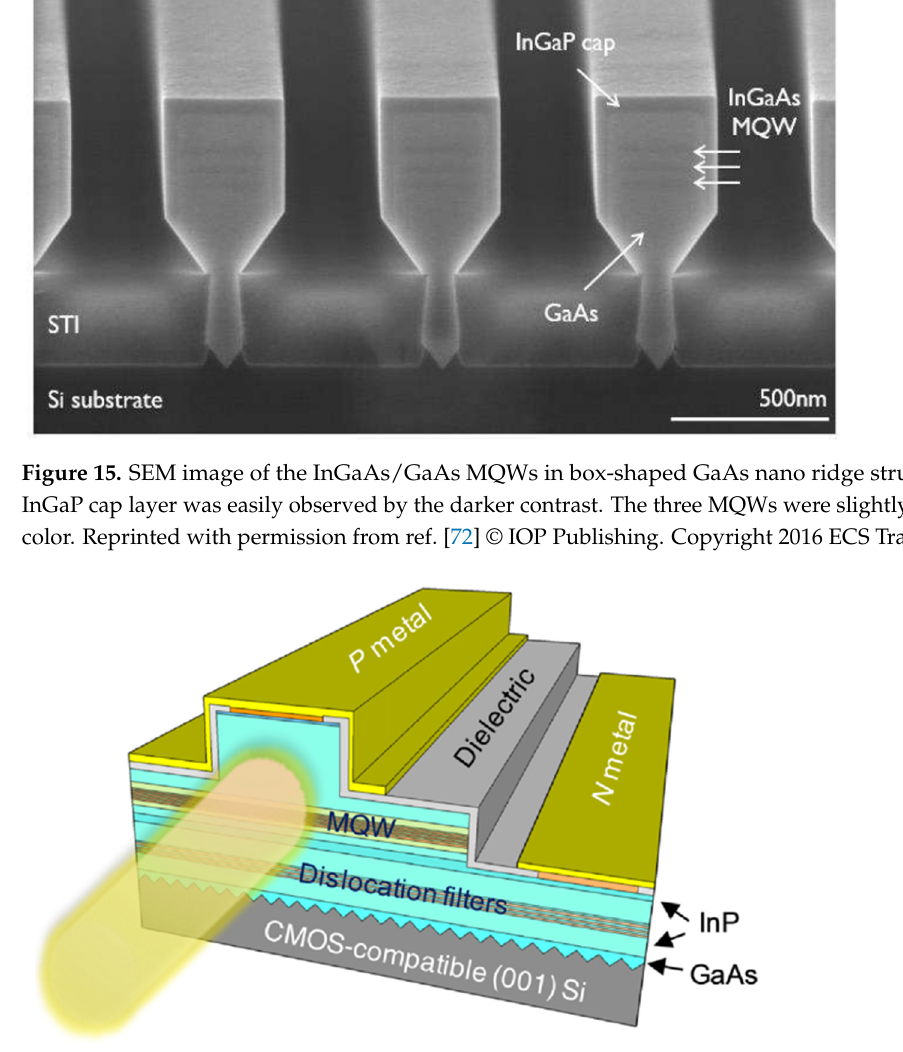
Figure 15. SEM image of the InGaAs/GaAs MQWs in box-shaped GaAs nano ridge structure; the InGaP cap layer was easily observed by the darker contrast. The three MQWs were slightly lighter in color. Reprinted with permission from ref. [72] © IOP Publishing. Copyright 2016 ECS Transac- tions.